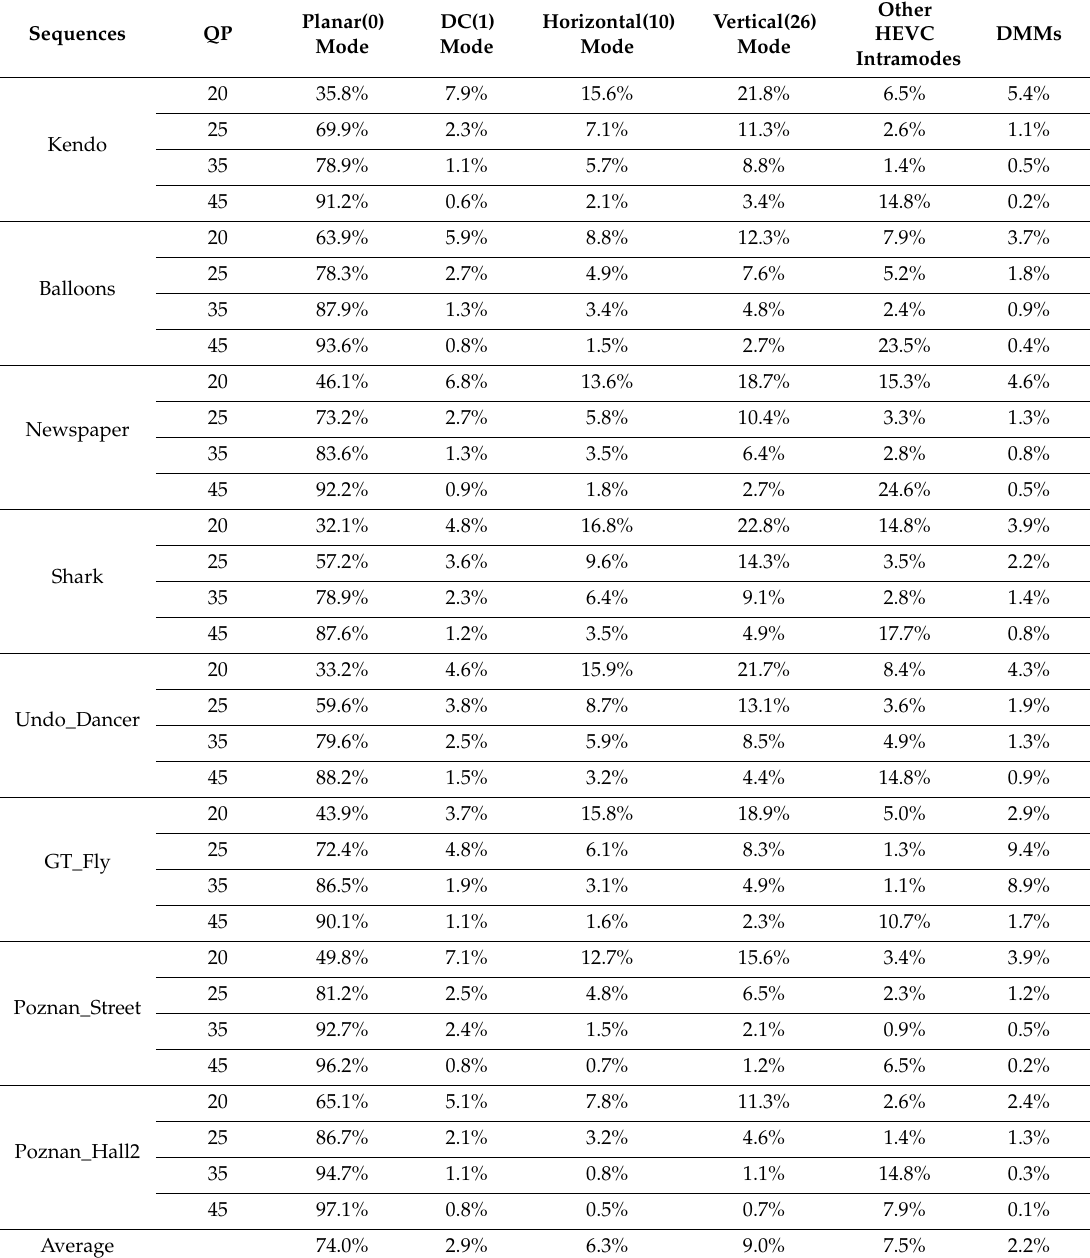
Table 2. Intramode distribution for depth